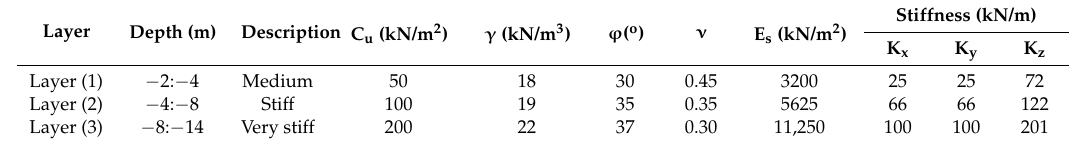
Table 3. Properties of the three soil